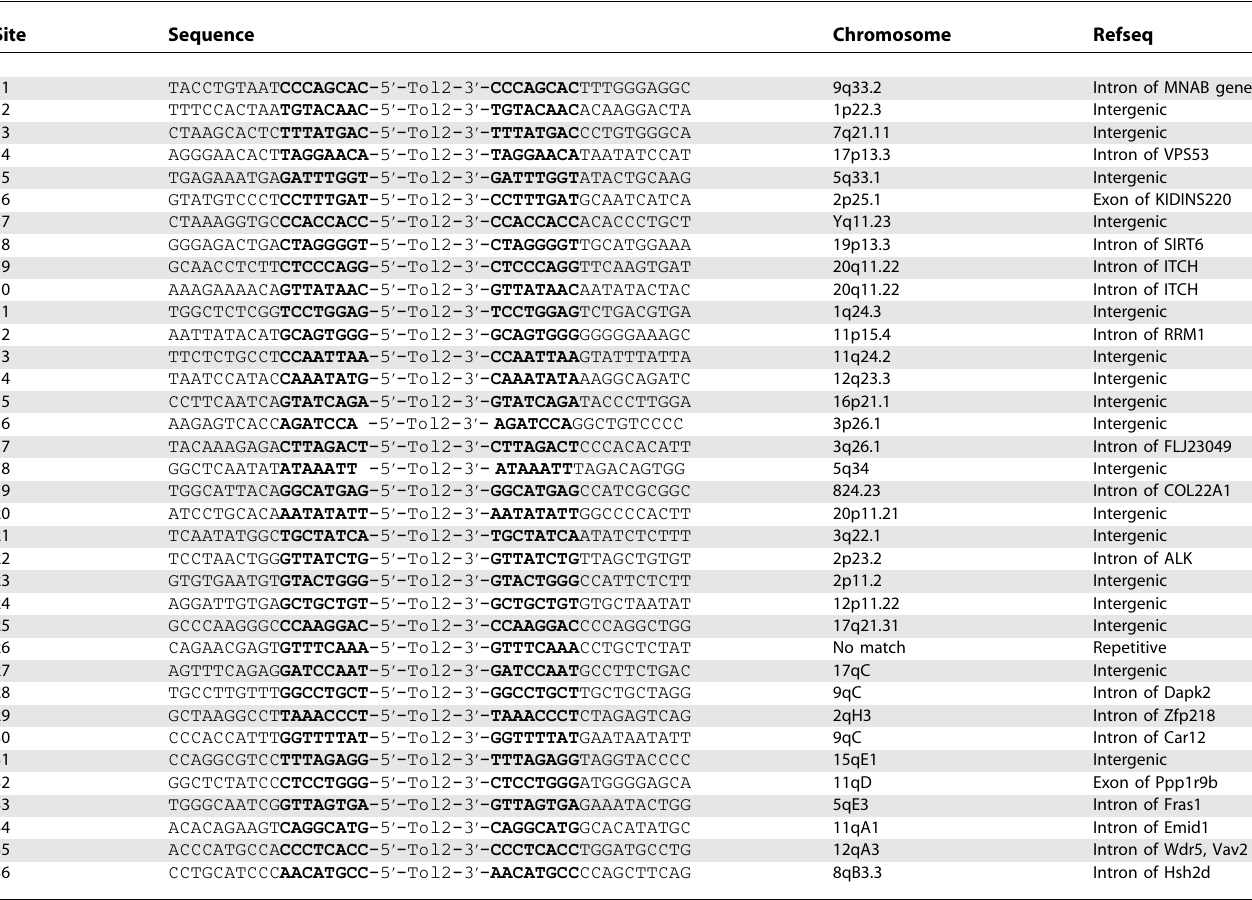
Table 1. Tol2 Insertion Sites Cloned from Human HT1080 Cells and Mouse Liver pTol2/SVneo Colonies, HT1080 Cells Site Sequence Chromosome